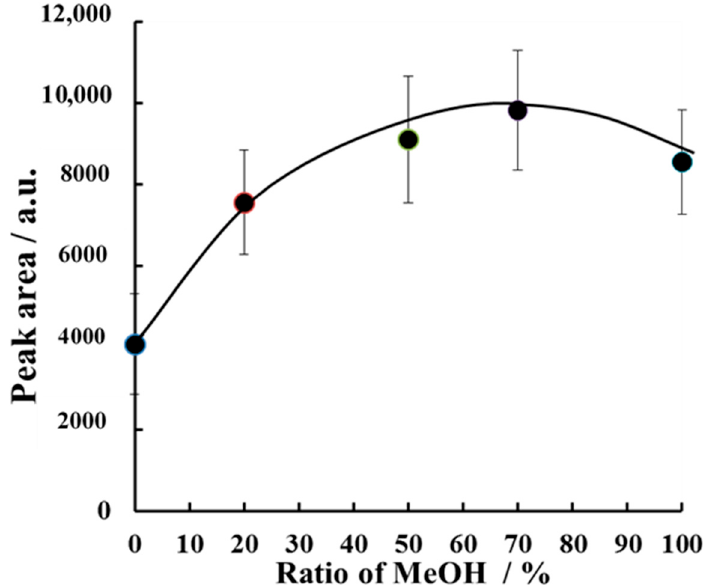
Figure 4. Dependence of the caffeine peak area on the ratio of MeOH in the extraction solvent for H-F heating extraction. The sample mass was 10 mg and the H-F heating extraction was carried out for 3 min at 220 °C. Error bars represent the standard deviation ( n = 3).